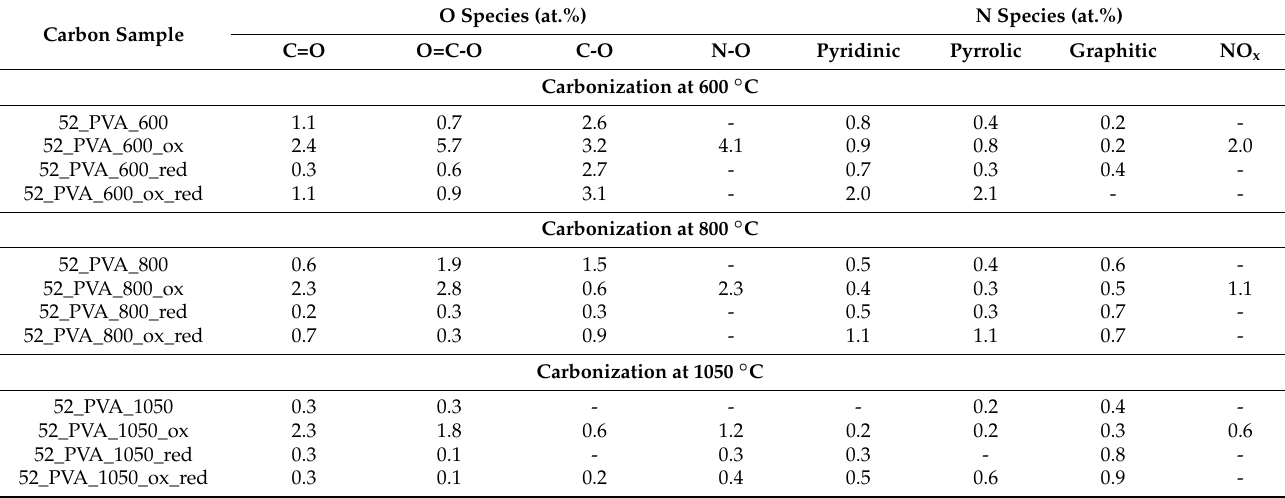
Table 3. Contents of O and N species on the surface of the resol resin-derived carbon materials carbonized at different temperatures and subsequently modified in an oxidizing/reducing atmosphere. Carbon Sample